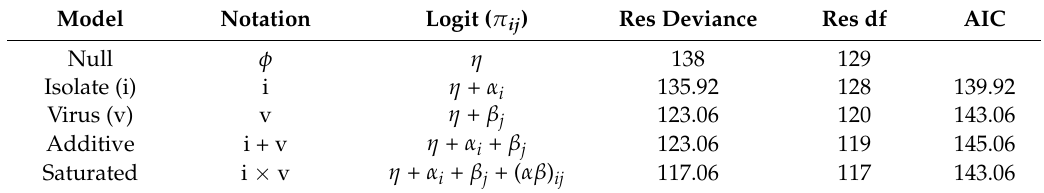
Table 3. Deviance in models of transmission of mitoviruses by F. circinatum isolates and strain of virus. The name of the model, a descriptive notation, the formula for the linear predictor, the residual deviance (or goodness of fit likelihood ratio chi-squared statistic), the residual degrees of freedom (Res df), and the Akaike Information Criterion (AIC) are